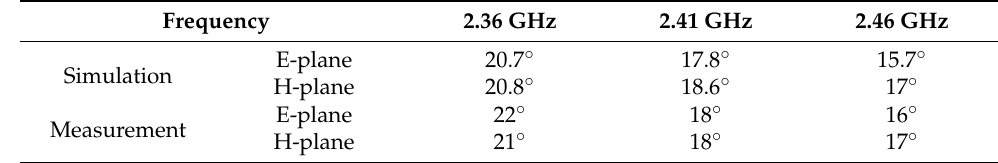
Table 1. The 3-dB beamwidth according to